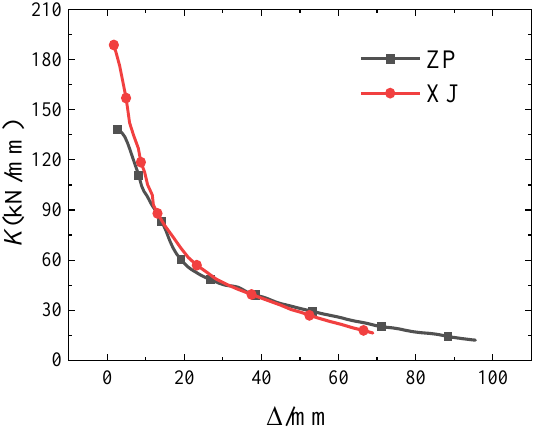
Figure 11. Stiffness degradation curves of specimens XJ and ZP.